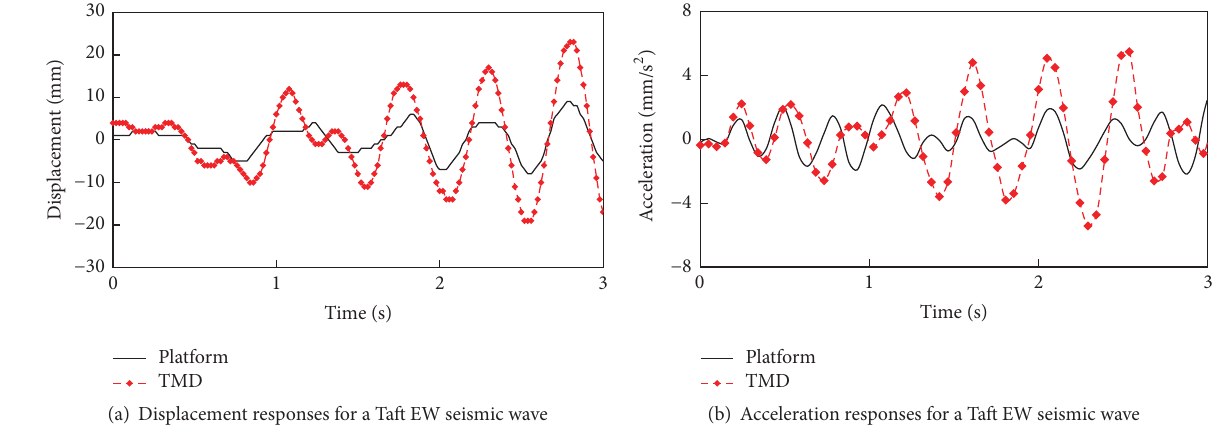
Figure 15: Experimental responses of the bufferable TMD and platform for the Taft EW seismic